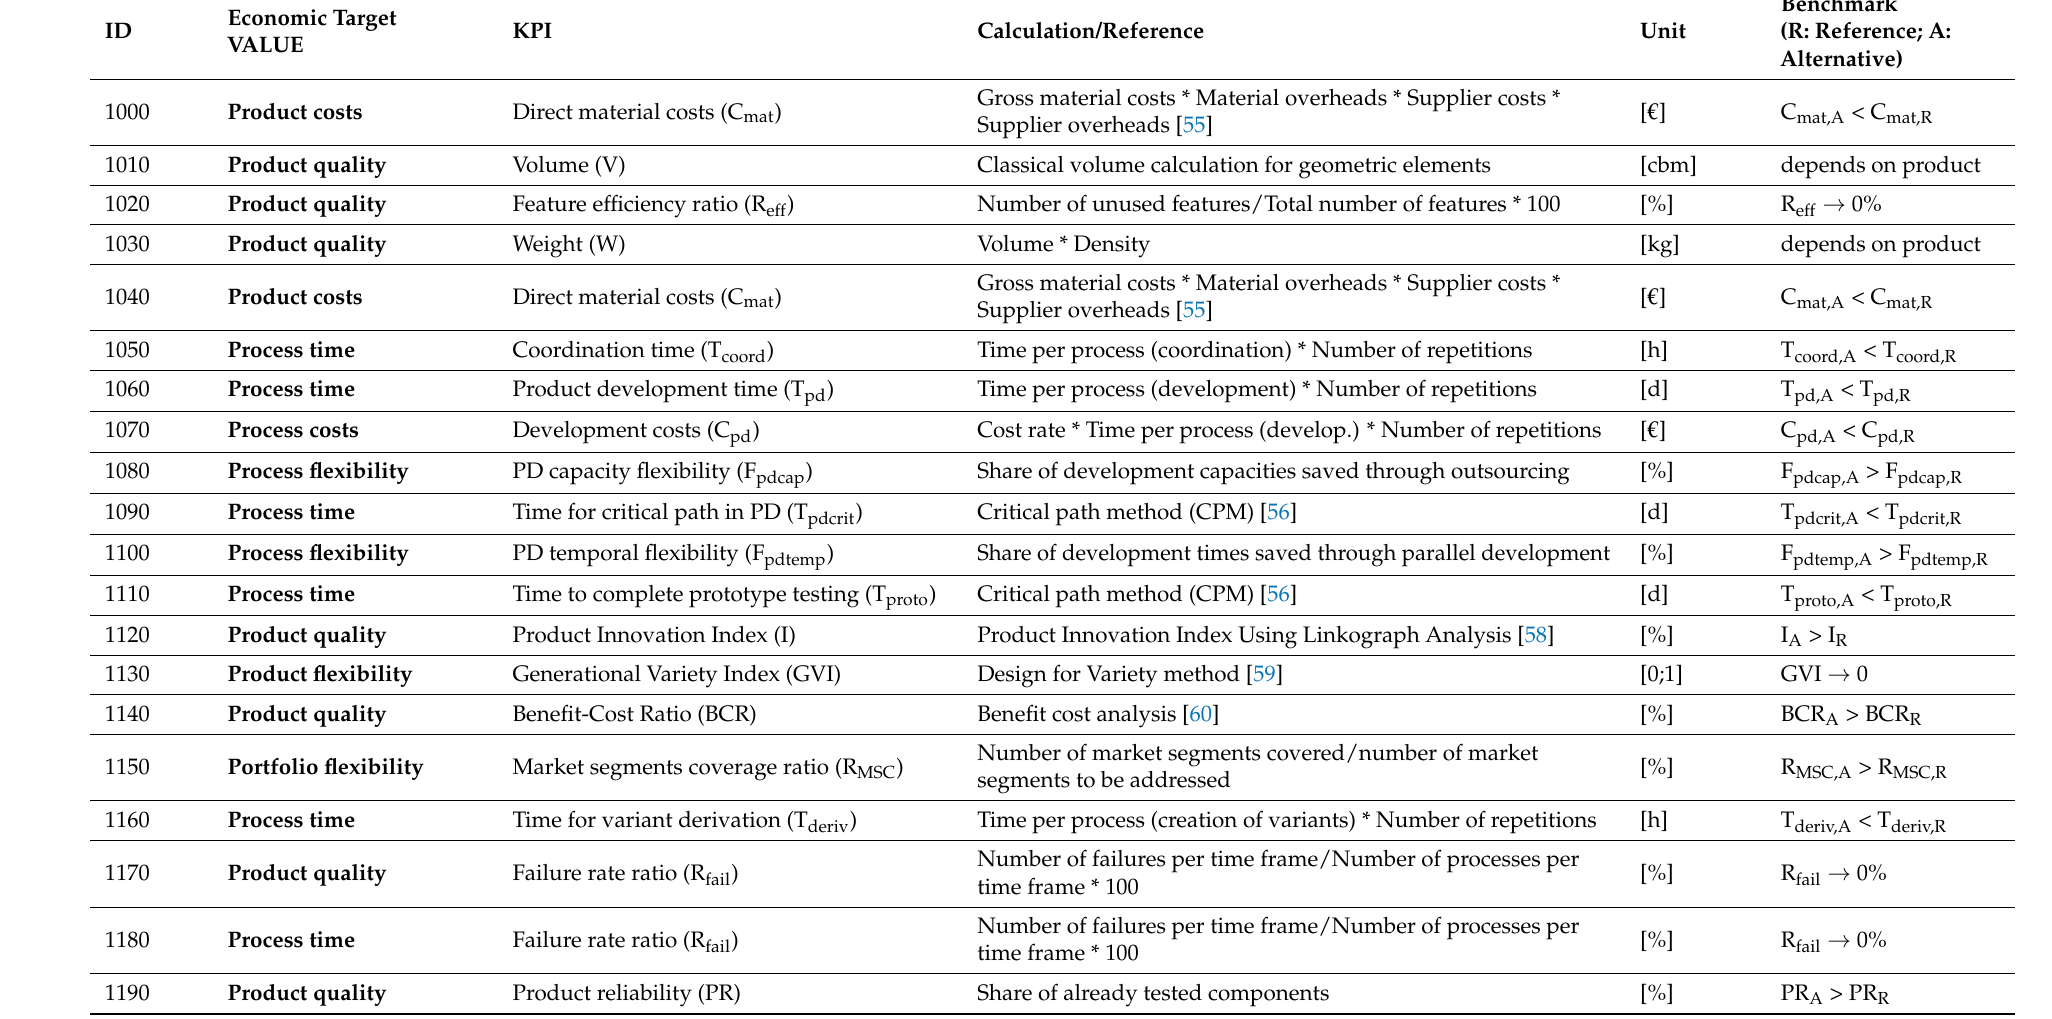
Table 2. KPIs and calculation principles for determining economic targets in the